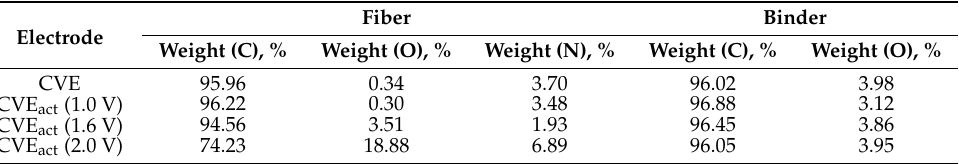
Table 1. Elemental composition of CVE and CVE act surfaces with different treatments.